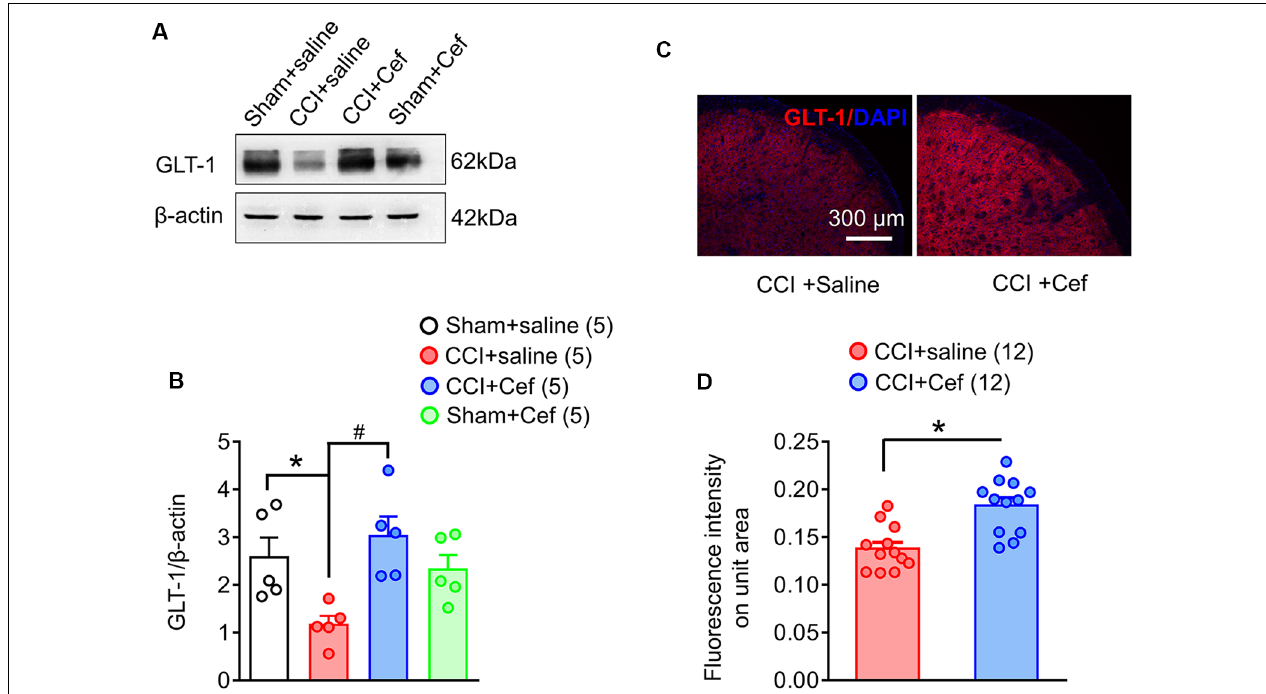
FIGURE 3 | Reversal effects of repeated systemic administration of ceftriaxone (Cef) on CCI-ION-induced loss of GLT-1 protein in the medullary dorsal horn. Panels (A,B) show expression of GLT-1 protein in the ipsilateral medullary dorsal horn of rats with Sham + saline ( n = 5), CCI-saline ( n = 5), CCI-Cef ( n = 5) and Sham + Cef ( n = 5). Data are presented as mean ± SEM. * p < 0.05, CCI + saline vs. Sham + saline; # p < 0.05, CCI + Cef vs. CCI + saline. (C,D) Immunofluorescent staining of GLT-1 (red) and DAPI (blue) in the ipsilateral medullary dorsal horn of CCI + saline ( n = 12) and CCI + Cef ( n = 12) groups. Data are shown as mean ± SEM. * p < 0.05, CCI + Cef vs. CCI + saline. GLT-1, glutamate transporter 1.